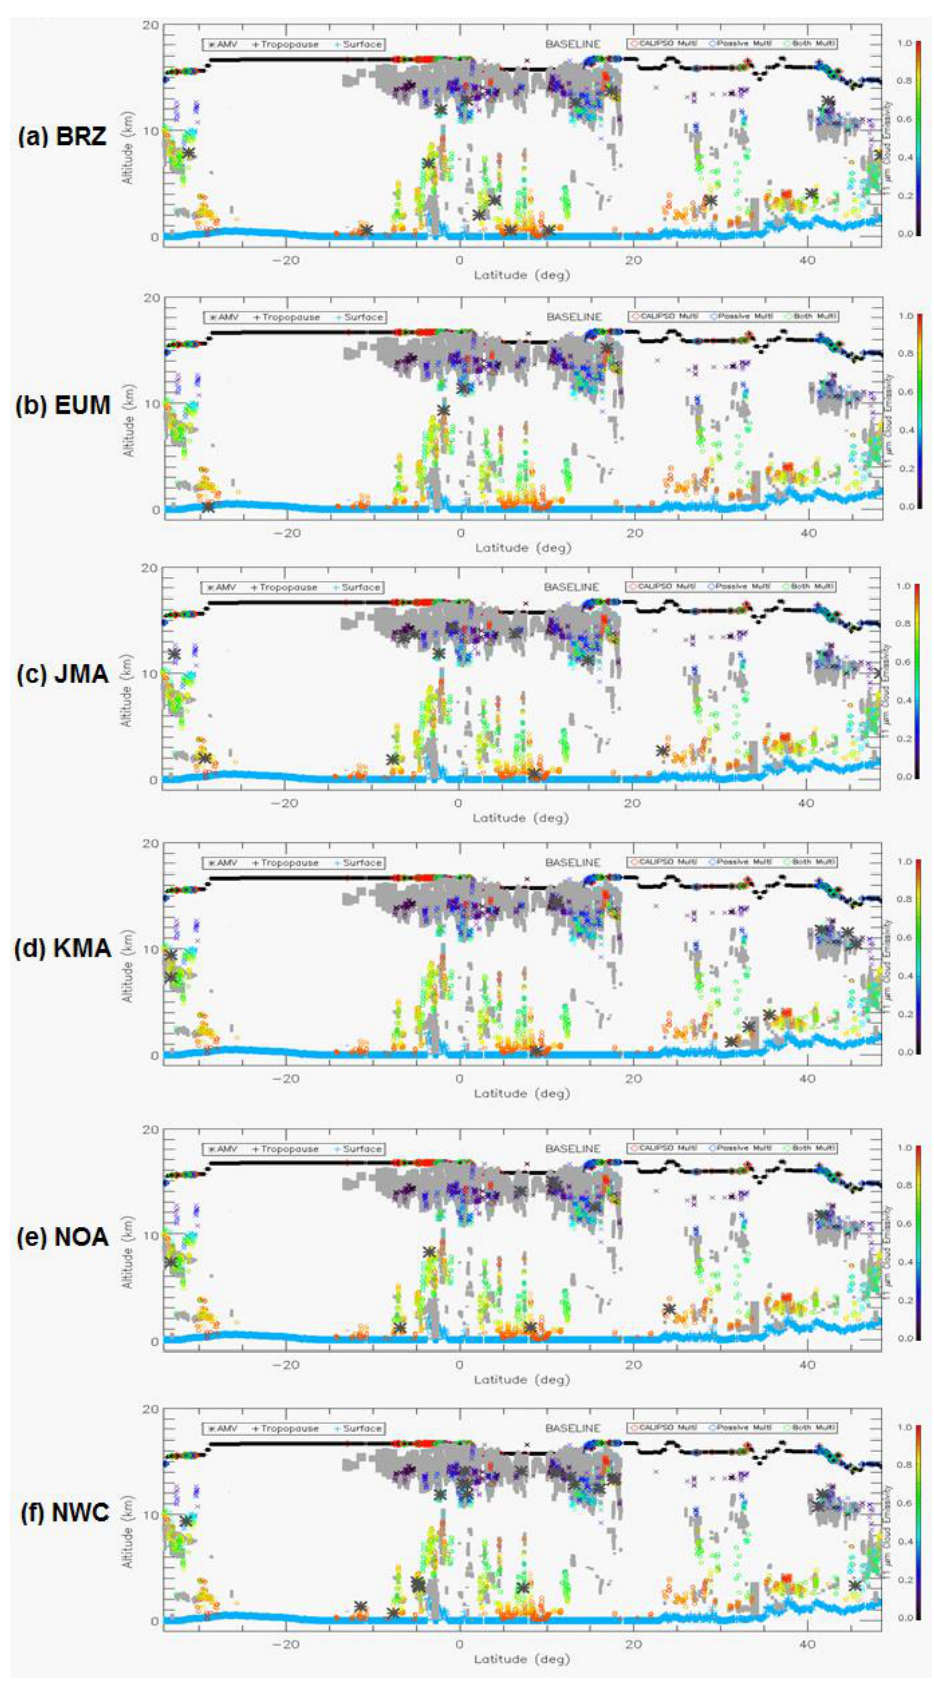
Figure 11. Experiment 3: Collocation of AMVs (defined as black asterisks *) with CALIPSO cloud measurements for ( a ) BRZ, ( b ) EUM, ( c ) JMA, ( d ) KMA, ( e ) NOA, ( f ) NWC.